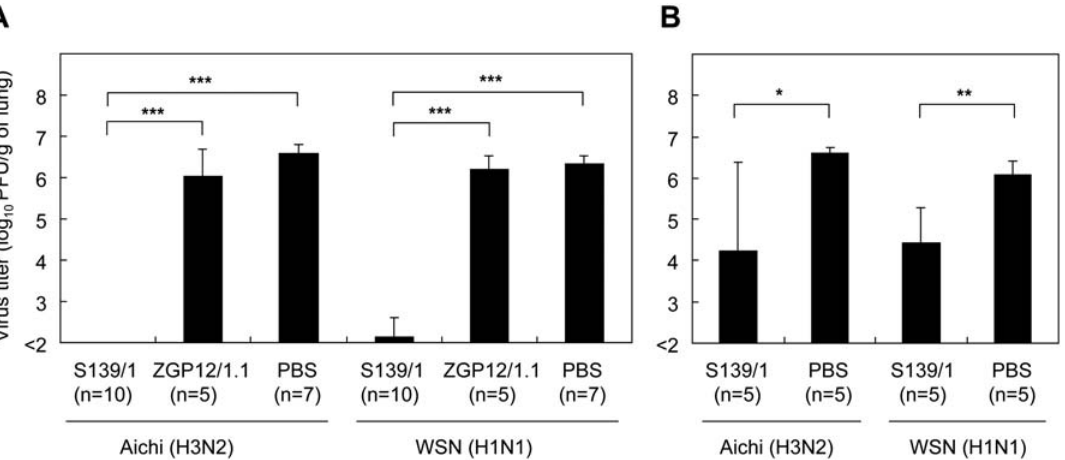
Figure 3. Protective efficacy of passive immunization with MAb S139/1 in mice. Mice were passively immunized before (A) or after (B) virus challenge with Aichi (H3) or WSN (H1). Control mice were given MAb ZGP12/1.1 or PBS. Virus titers of the lung were determined by a plaque assay. The means and standard deviations are shown. For statistical purposes, samples with undetectable virus titers were given the value 2.0 log 10 PFU/g. The data of pre-immunized mice were analyzed using the nonparametric Kruskal-Wallis ANOVA on ranks, followed by the Mann-Whitney U-test with the Bonferroni correction for multiple comparisons. The data of post-immunized mice were analyzed using the Mann-Whitney U-test. Two-sided p values less than 0.05 were considered statistically significant. Significant differences were indicated by asterisks (*** p , 0.001, ** p , 0.01, * p , 0.05). All statistical analyses were performed with the computer program R (version 2.8.1).